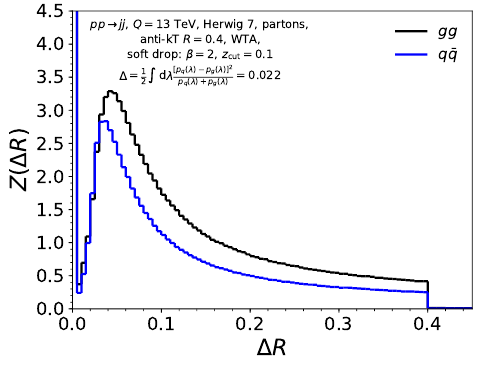
Figure 16 . Jet shape at the LHC for jets with p (blue) and pp ! gg (black). Note that the curves have been normalized in the whole range, i.e. with (cid:1) R min = 0 :